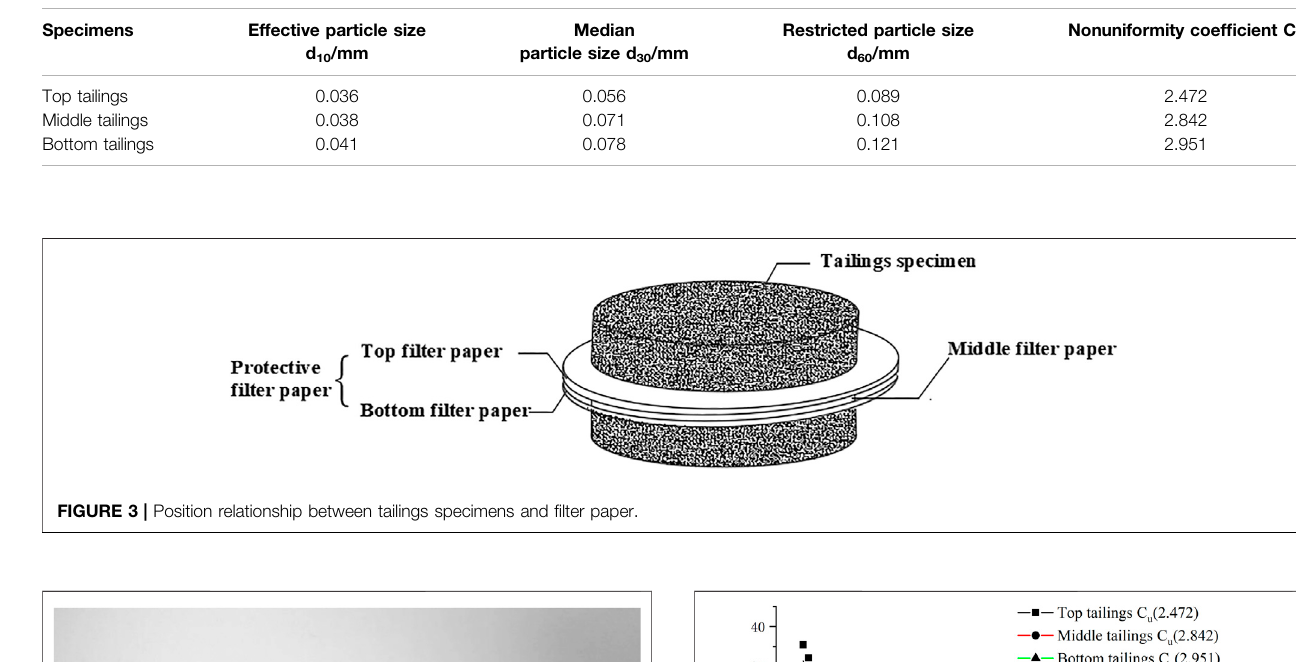
TABLE 2 | The particle characteristics of different sedimentary tailings.